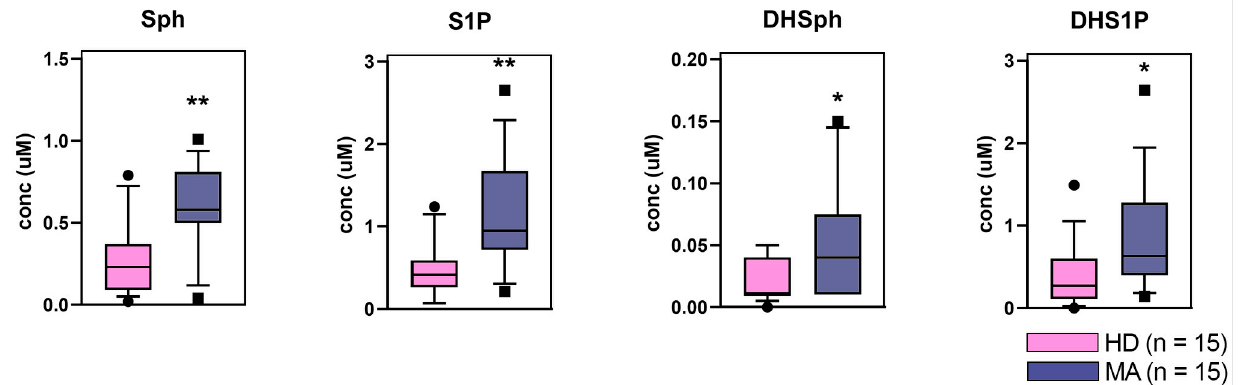
Figure 4. Quantitative evaluation of plasma sphingoid bases in MA patients (MA, n = 15) in comparison to age and sex matched healthy donors (HD, n = 15). Statistical significance was evaluated by unpaired t -test. p values are schematized as follows: * < 0.05; ** < 0.01.